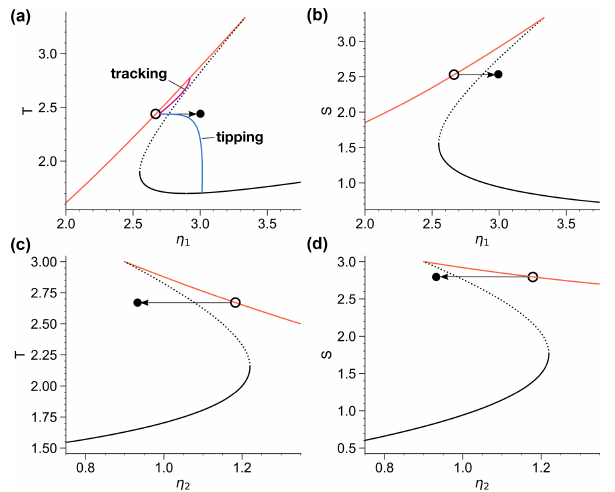
Figure 4. (a, b) Bifurcation diagram of the Stommel model equi- libria in terms of the variables (a) T and (b) S as a function of η 1 as control parameter with η 2 = 1 . 0 and η 3 = 0 . 3. (c, d) The same as (a, b) but with η 2 as control parameter with η 1 = 3 . 0 and η 3 = 0 . 3. Solid lines indicate stable fixed points, whereas dotted lines indi- cate saddle points. The horizontal arrows indicate the movement of the system state as the control parameter is changed instantaneously within the bi-stable regime. In (a) we illustrate how the system state may track the moving equilibrium for a slow parameter shift (pur- ple trajectory) or tip to the undesired equilibrium in a fast parameter change (blue